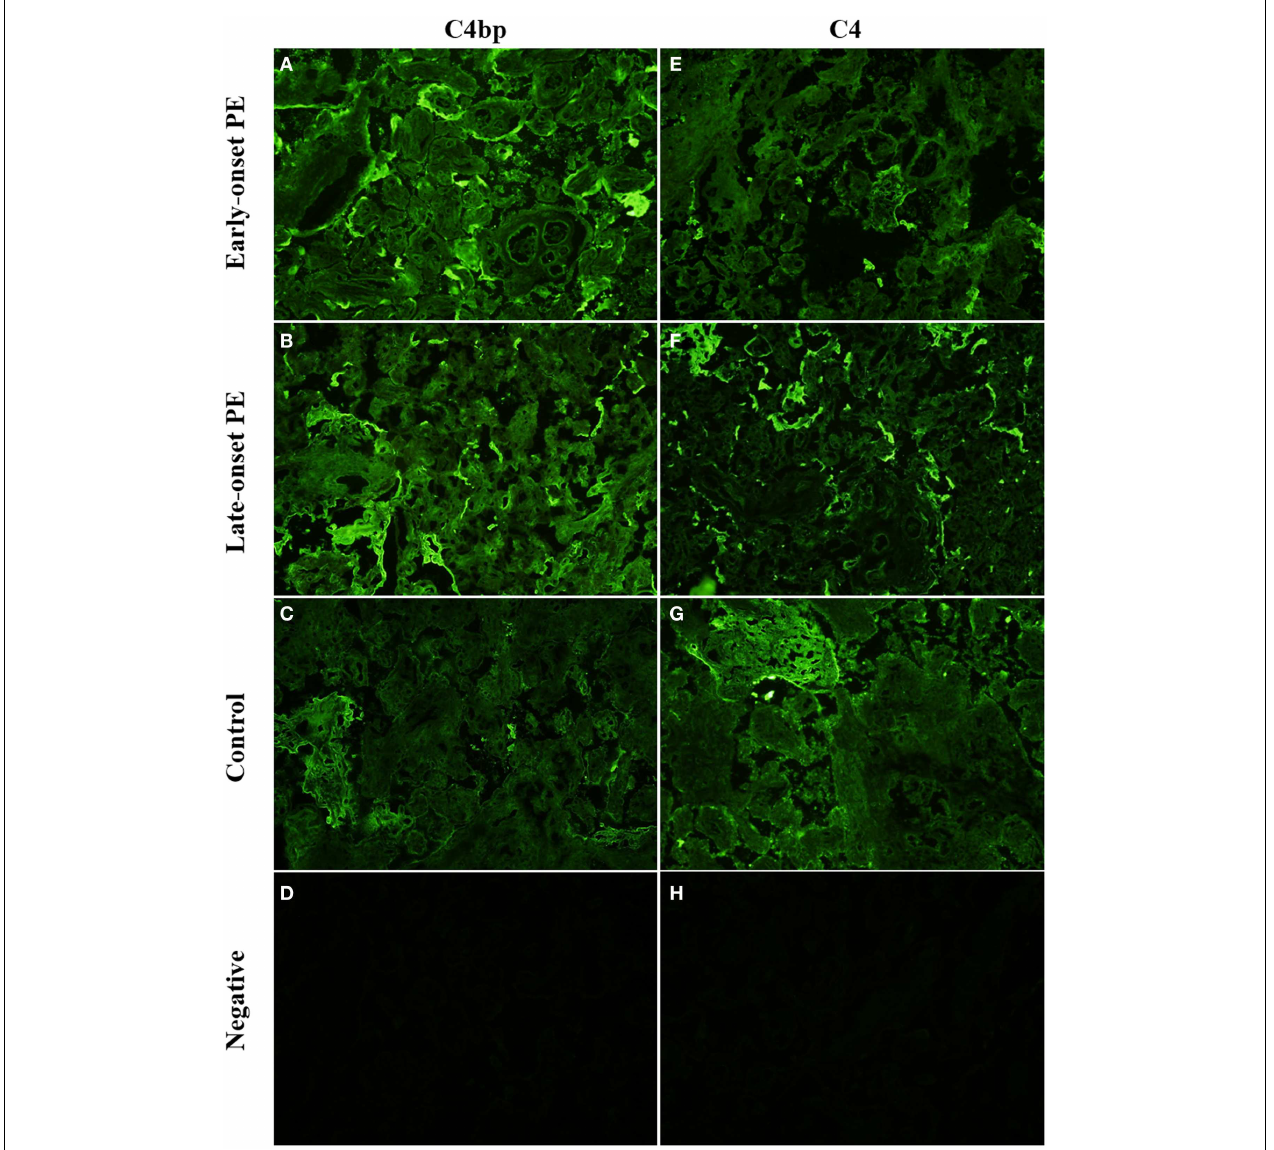
and C4bp are both observed in fibrinoid structures [here in control panels (G,C) ].Top row (A,E) : early-onset PE. Middle top row (B,F) : late-onset PE. Middle bottom row (C,G) : control. Bottom row (D,H) : negative control (antibody I omitted). 20 × magnification.